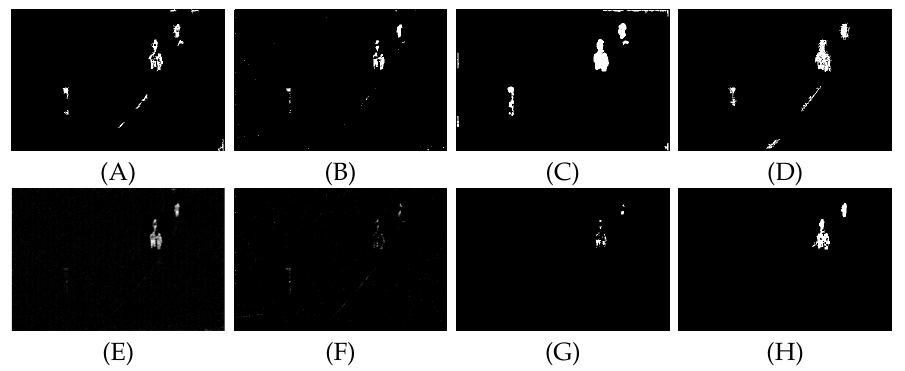
Figure 6. ( A – H ) show the detection results of eight algorithms PSTNN, TV-PCP, VNTFR, anisotropy, ASTTV, SRWS, RPCA and propose methods, respectively, under sequence A.